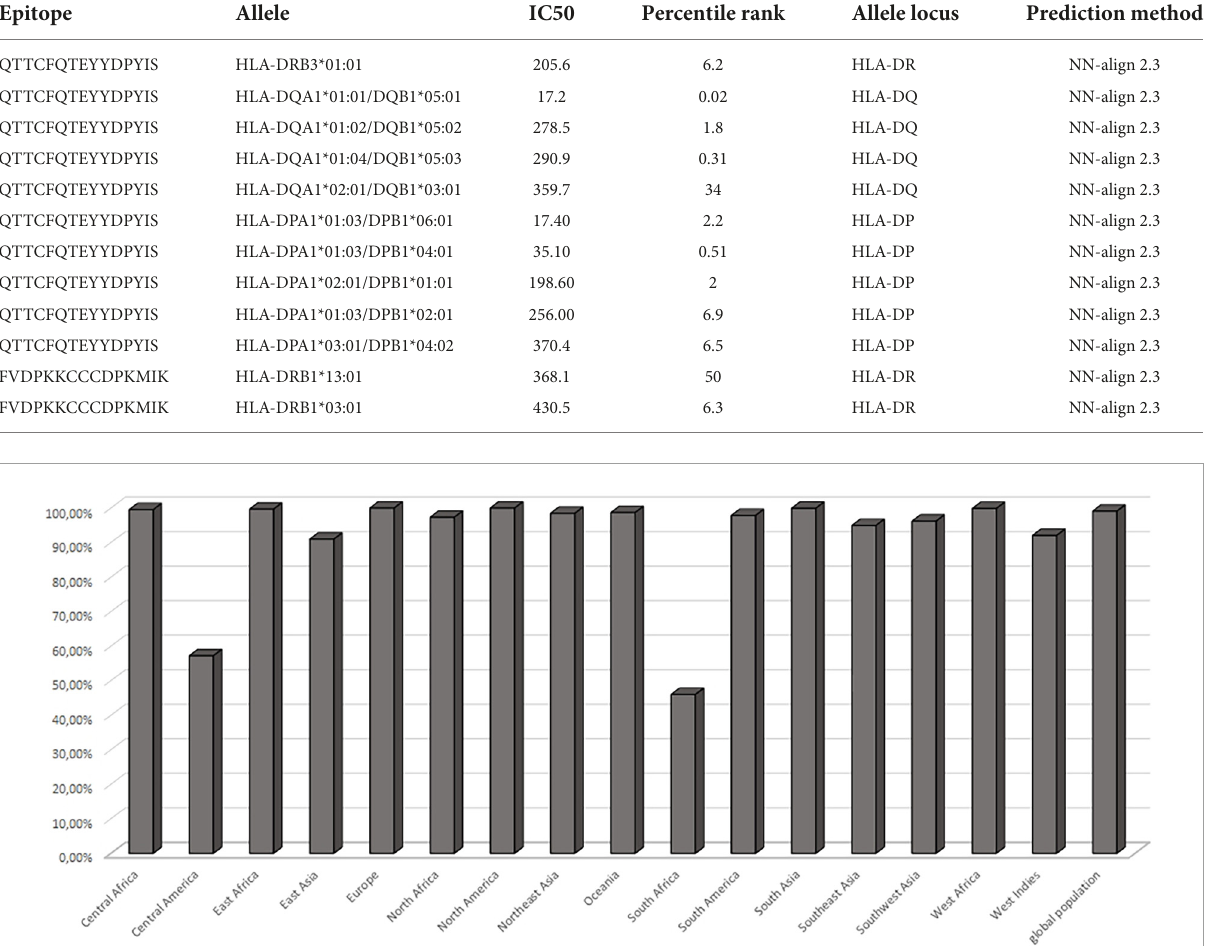
TABLE 2 List of selected alleles used for the population coverage analysis.